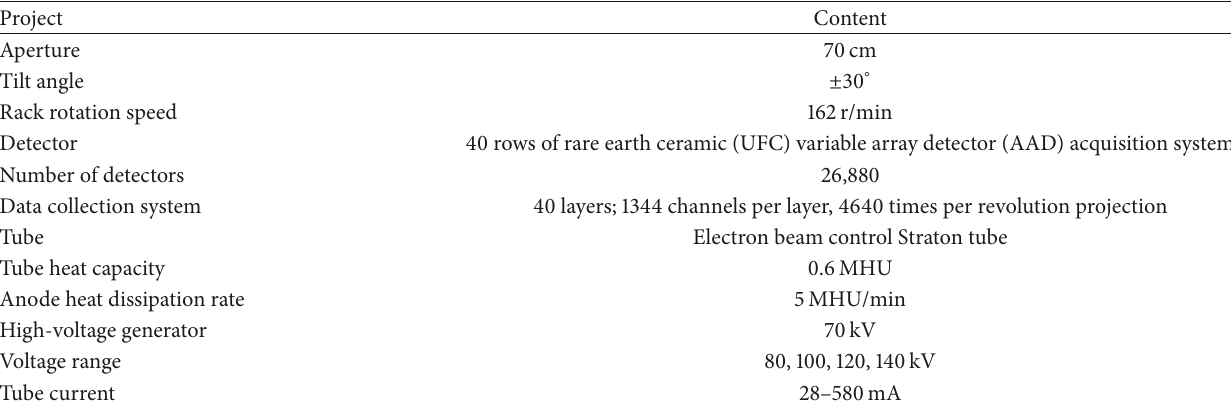
Figure 1: Investigation results for the main failure mode of mercury slag accumulation in the Tongren area: (a) types and (b) slope foot source damage. Table 3: Main technical parameters of SOMATOM Sensation 40.